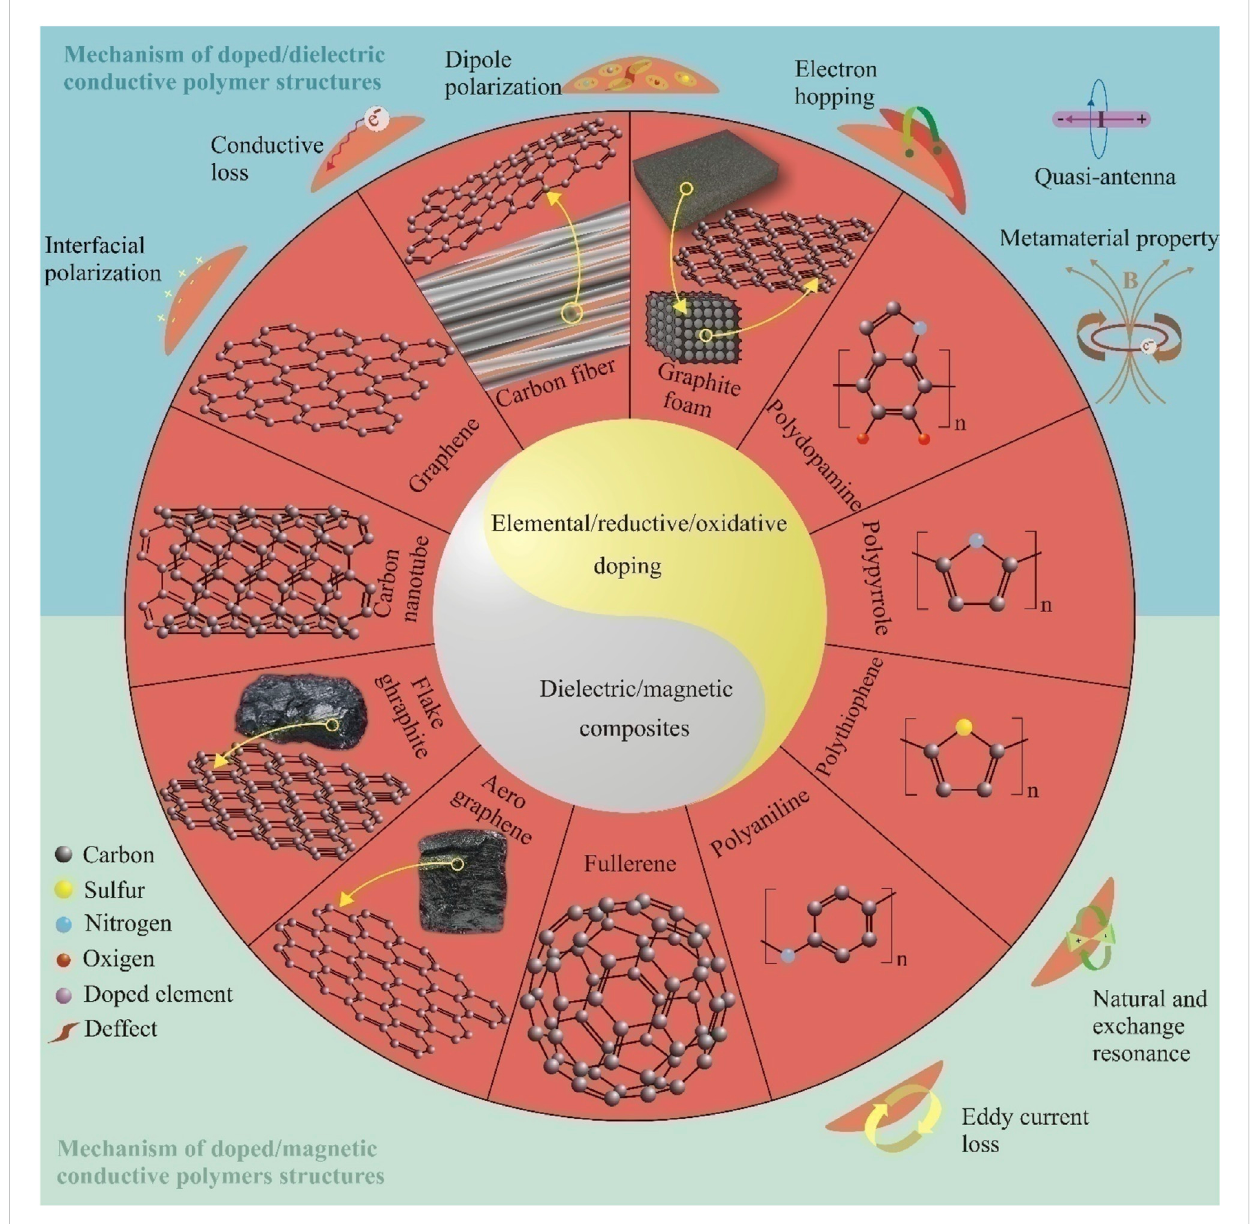
FIGURE 1 Schematic diagram of conductive polymer-based microwave-absorbing materials and the related microwave-absorbing mechanisms.